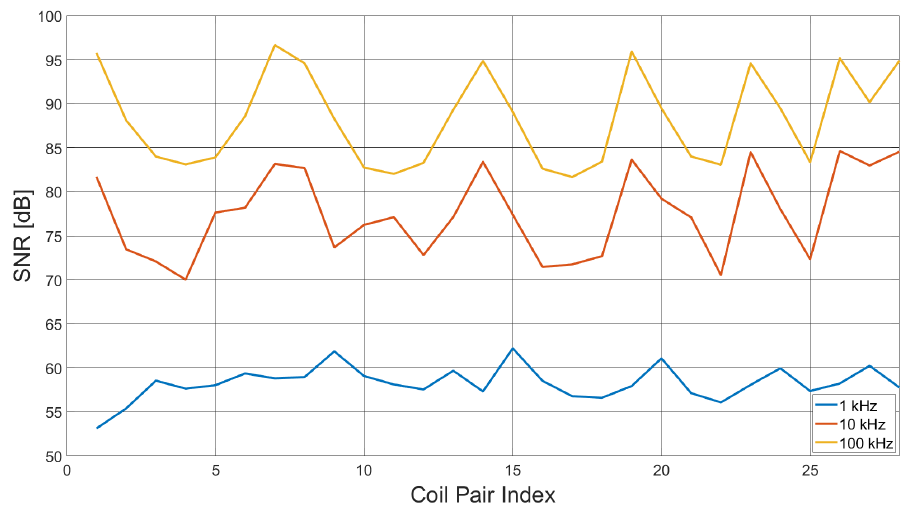
Figure 6. Frame data SNR for excitation field frequencies 1, 10 and 100